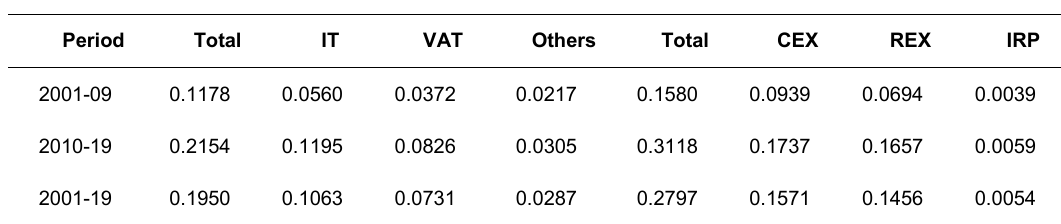
Table 4 Contribution of Automatic Fiscal